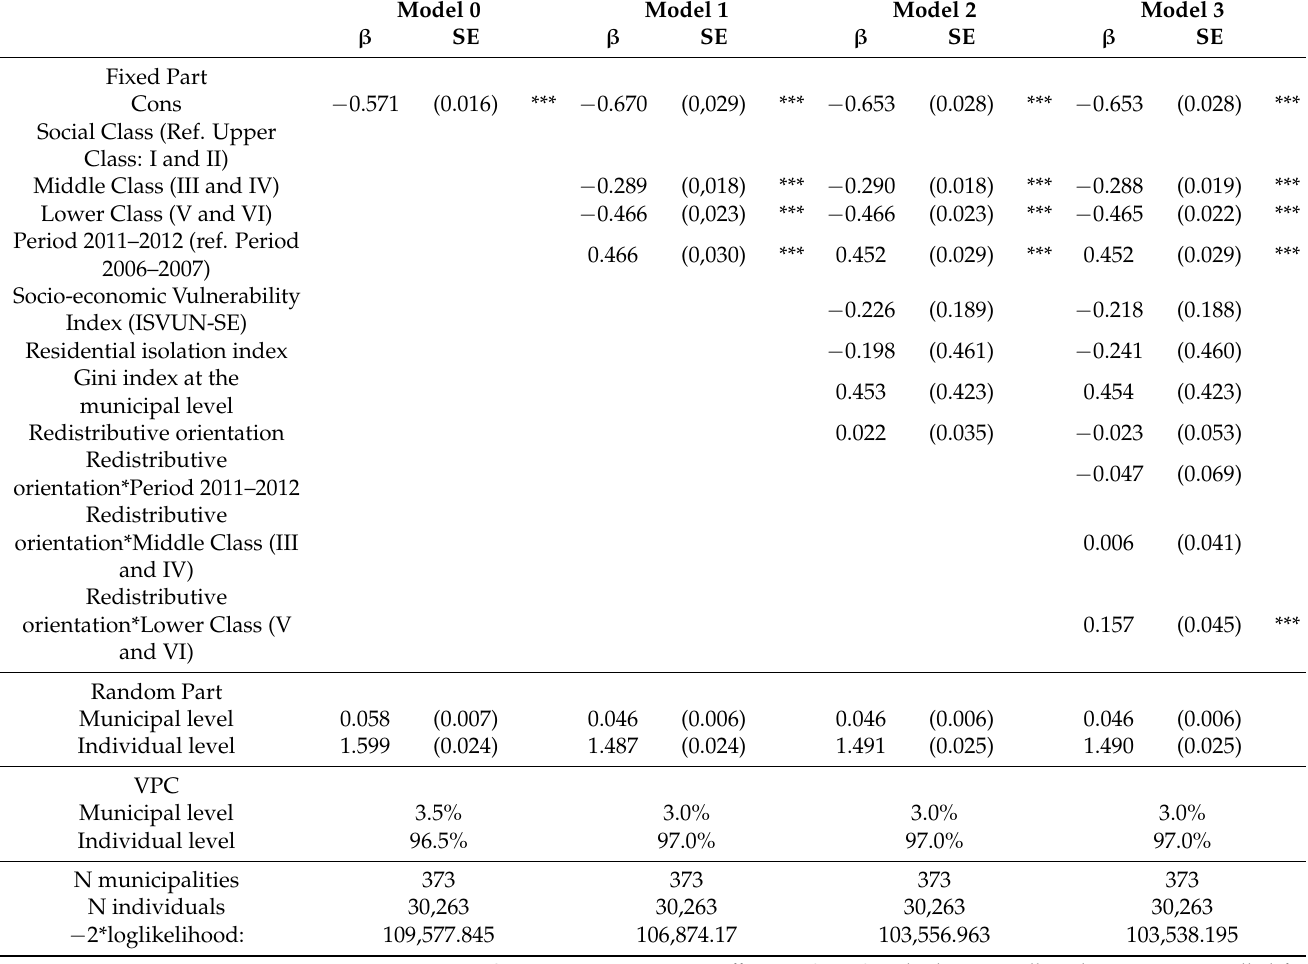
Table 4. Multilevel models for healthy practices. Model 0 Model 1 Model